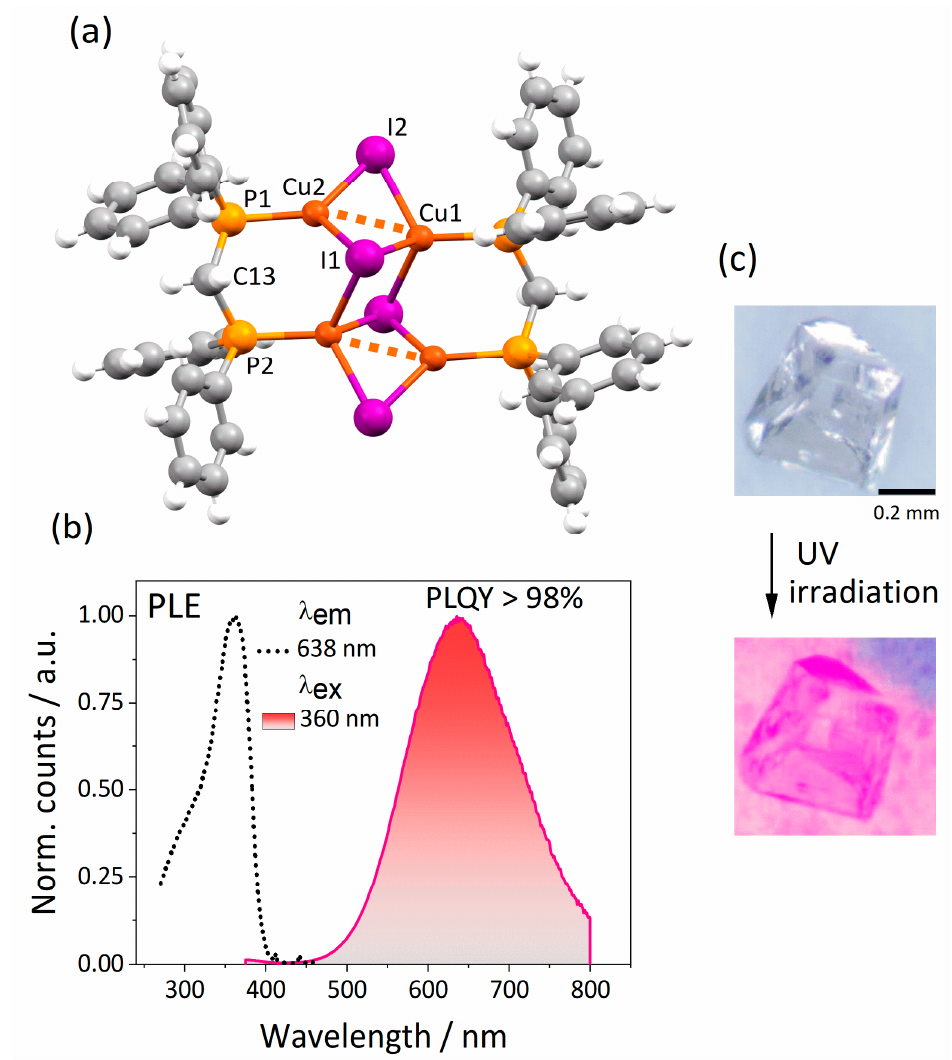
Figure 1. ( a ) Crystal structure of [bppmCu 2 I 2 ] 2 at 100 K. Cu: red, C: gray, P: yellow, I: purple, H: white. ( b ) The normalized emission ( λ ex = 360 nm) and excitation ( λ em = 638 nm) spectra of [bppmCu 2 I 2 ] 2 at room temperature. ( c ) Photographs of a 0.45 × 0.40 × 0.22 mm single crystal of [bppmCu 2 I 2 ] 2 , under natural light and 365 nm UV irradiation, respectively.